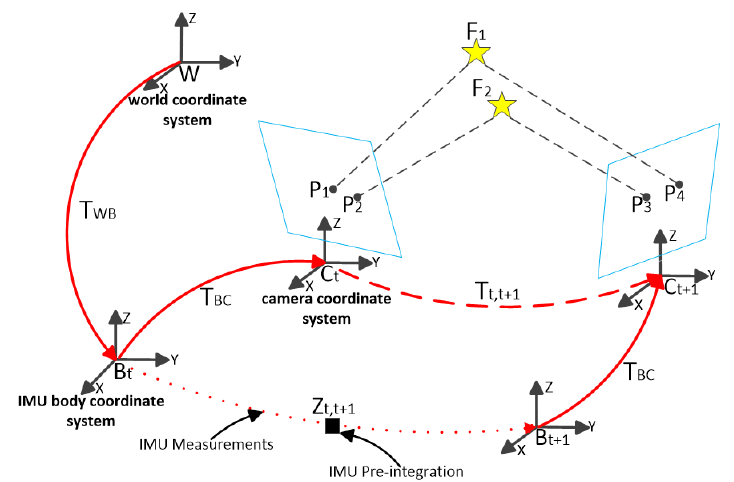
Figure 2. Symbol definition of algorithm